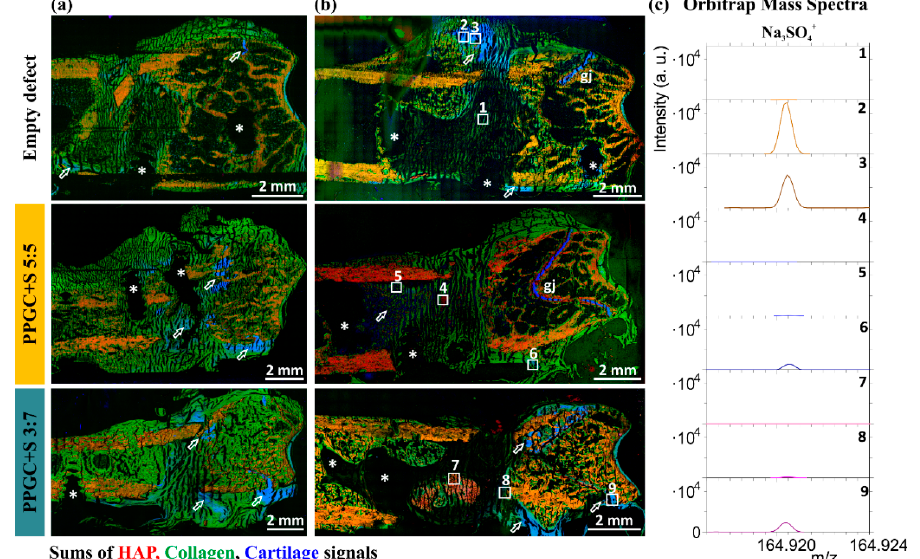
Figure 7. Overview ToF-SIMS mass spectrometric images of the empty group and bone sections containing PPGC + S 5:5 and PPGC + S 3:7 as a biomaterial. RGB overlay images show mass distribution of HAP (mineralized bone, red), collagen mass signals (green) (mass signals listed in Table S1) as well as signals related to cartilage (combination of sulfate signals Na 3 SO 4+ and Na 5 S 2 O 8+ ) in blue. ( a ) ToF-SIMS mass spectrometric images obtained with TOF.SIMS 5 (IONTOF GmbH, Münster, Germany) and 25 keV Bi 3+ primary ions. ( b ) 30 keV Bi 3+ primary ions were used for ToF-SIMS mass spectrometric images obtained with M6 Hybrid SIMS (IONTOF GmbH, Münster, Germany). ( c ) For precise spectrometric measurements, Q Exactive™ orbital trapping mass spectrometer was used with 20 keV Ar 8000 + clusters as primary ion species. Mass spectra were measured on di ff erent indicated by white rectangles). The white hollow arrows indicate cartilage tissue, white asterisks